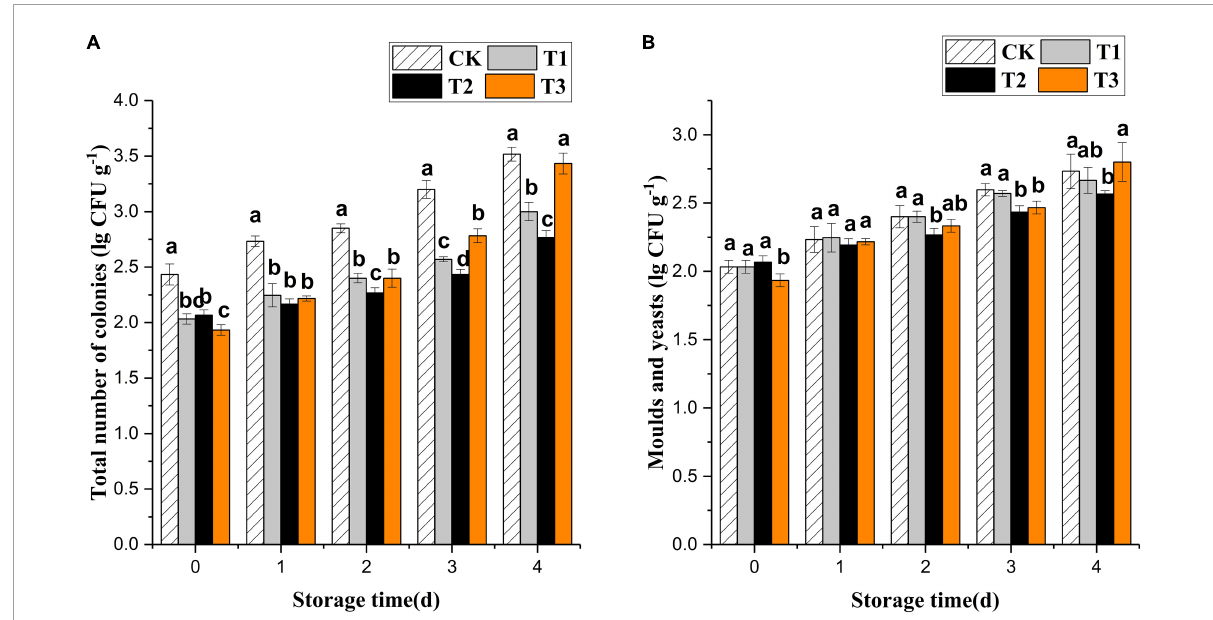
FIGURE1 Effect of ozone treatments on total number of microbial colonies (A) and molds and yeasts (B) of fresh-cut pitaya during storage. Data were expressed as means ± standard deviations (SD) from three